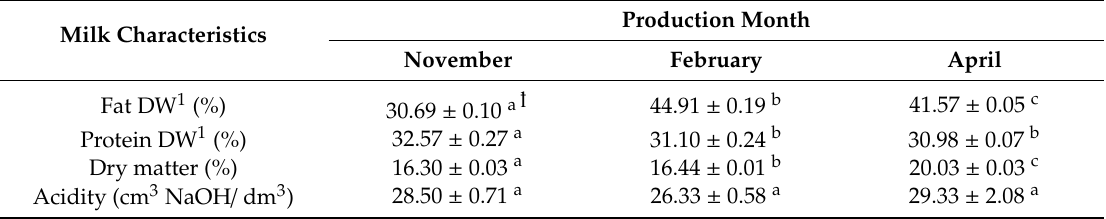
Table 1. Characteristics of the milk used in the production of PDO Serra da Estrela cheese. Milk Characteristics ꝉ Different letters indicate significant differences between groups (p < 0.05).